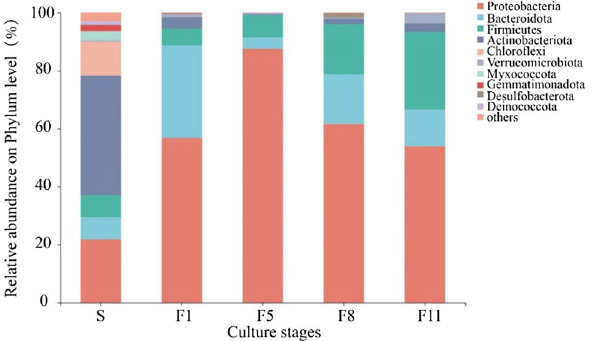
Figure 6. Community composition and relative abundance of bacteria at the phylum level at different culture stages. Abundances of taxa less than 1% were classified as other.